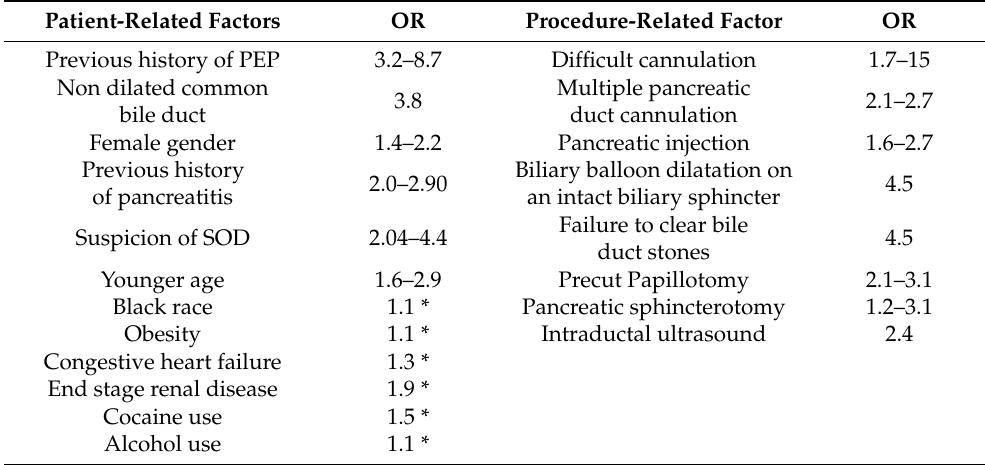
Table 2. Excerpt of patient and ERCP-related risk factors for PEP (adapted from Dumonceau 2020 and * Mutneja 2020). OR: Odds Ratio; PEP: post-ERCP pancreatitis; SOD: Sphincter of Oddi